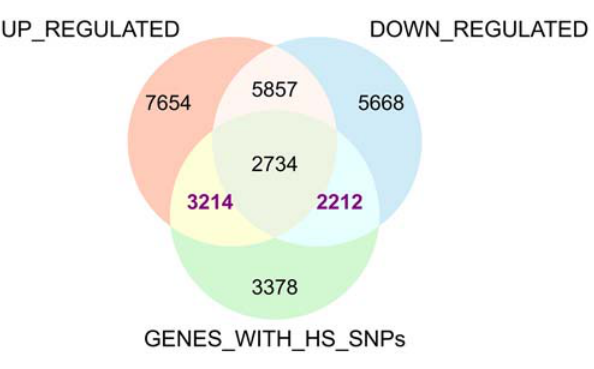
Genes 2022 , 13 , x FOR PEER REVIEW